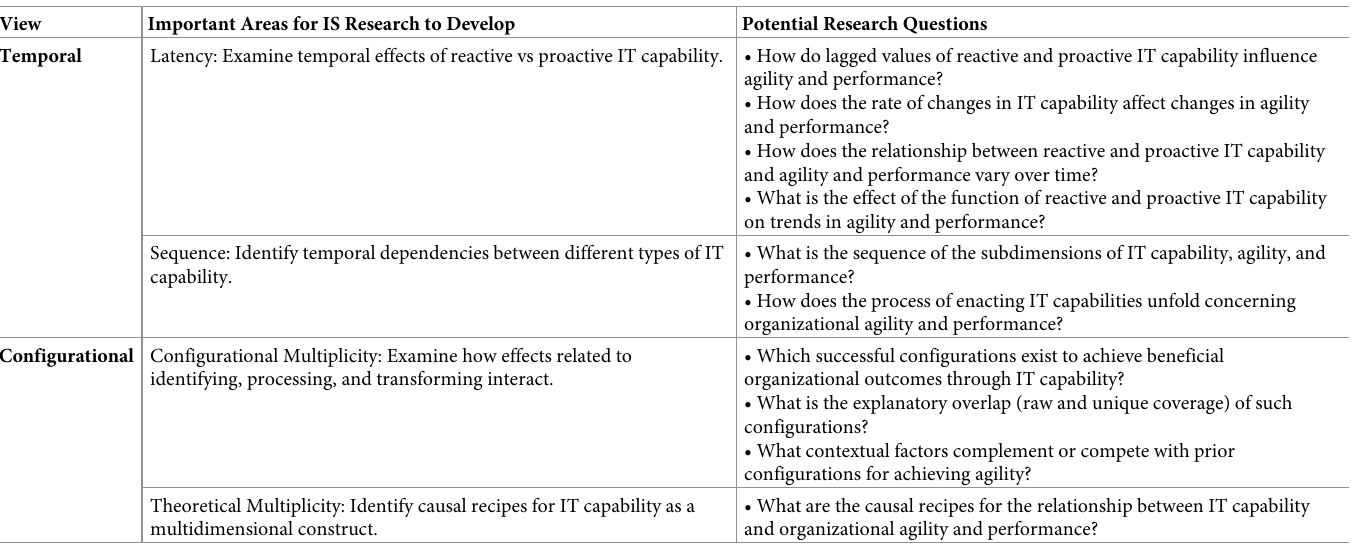
Table 6. Overview of future research